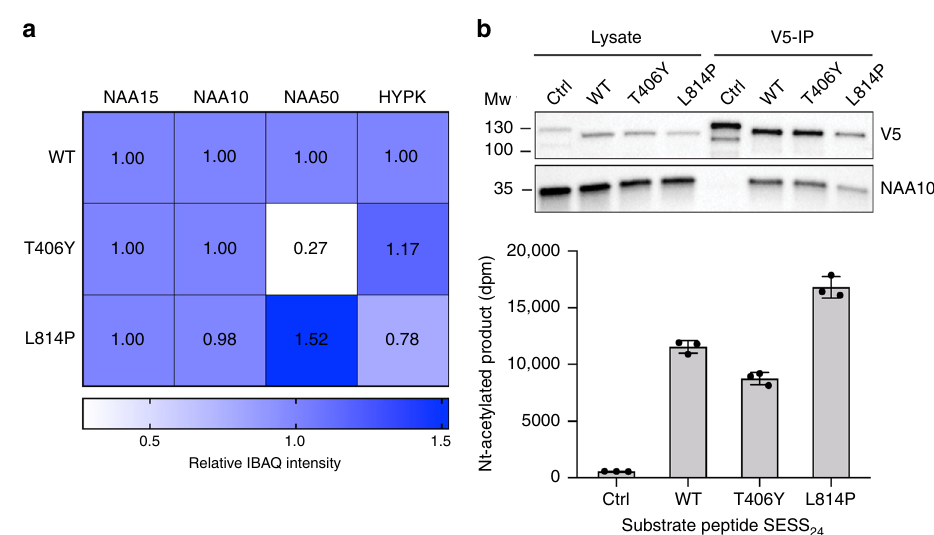
Fig. 3 hNatA forms competing complexes with hNAA50 and HYPK. a Heat map showing the mean relative IBAQ intensity of NatA components from three independent MS analyses of immunoprecipitated NAA15 variants, NAA15-WT-V5, NAA15-T406Y-V5, and NAA15-L814P-V5. The IBAQ intensities of each component were normalized to the IBAQ intensity of NAA15 in the respective sample and to the corresponding NatA WT protein. Source data are provided as a Source Data fi le. b Western blot analysis and NatA Nt-acetylation assay of V5-immunoprecipiated NAA15 variants. The measured DPM signal for each reaction was normalized to the corresponding V5-band in the IP. The immunoprecipitation and activity assay were performed in n = 3 independent experiments, each with three technical replicates (indicated by dot plots) per assay. Source data are provided as a Source Data fi